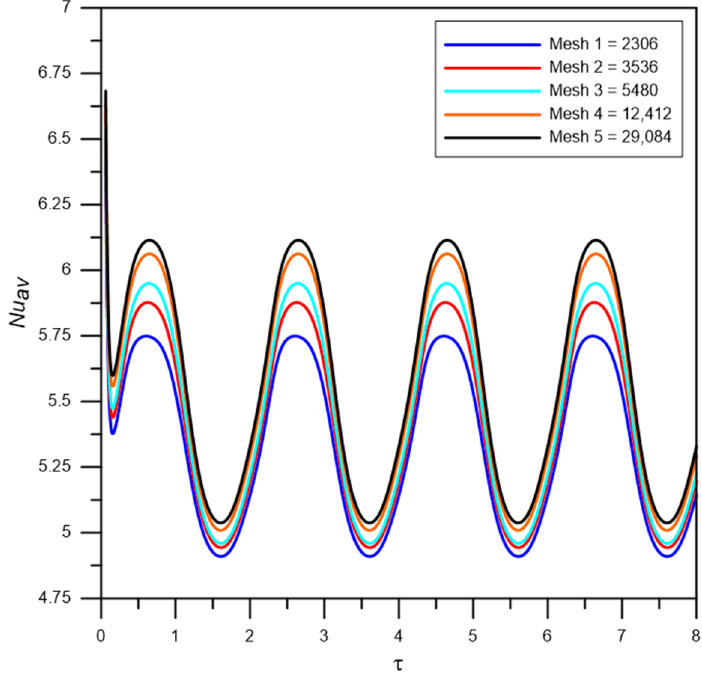
Figure 2. Mesh independency at A/L = 0.1, f = 0.25, φ = 0.05 and Ra = 10 6 .